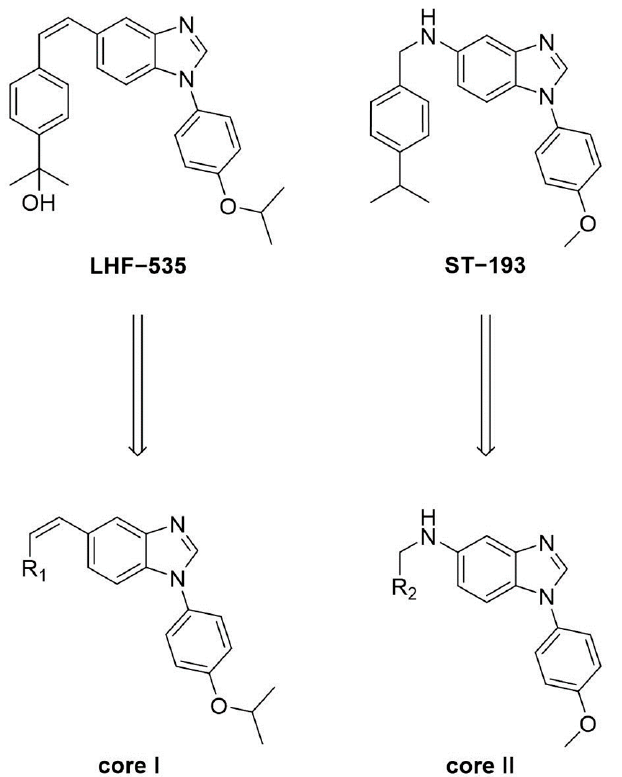
Figure 1. The structure of LHF − 535 and ST − 193 and two kinds of substituted benzimidazole struc- tures.